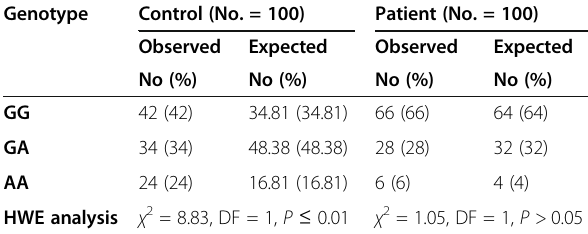
Table 3 Number and percentage frequencies (observed and expected) of ApoB gene (rs676210 SNP) genotype and their Hardy-Weinberg equilibrium (HWE) in patients and controls Genotype Control (No. = 100)